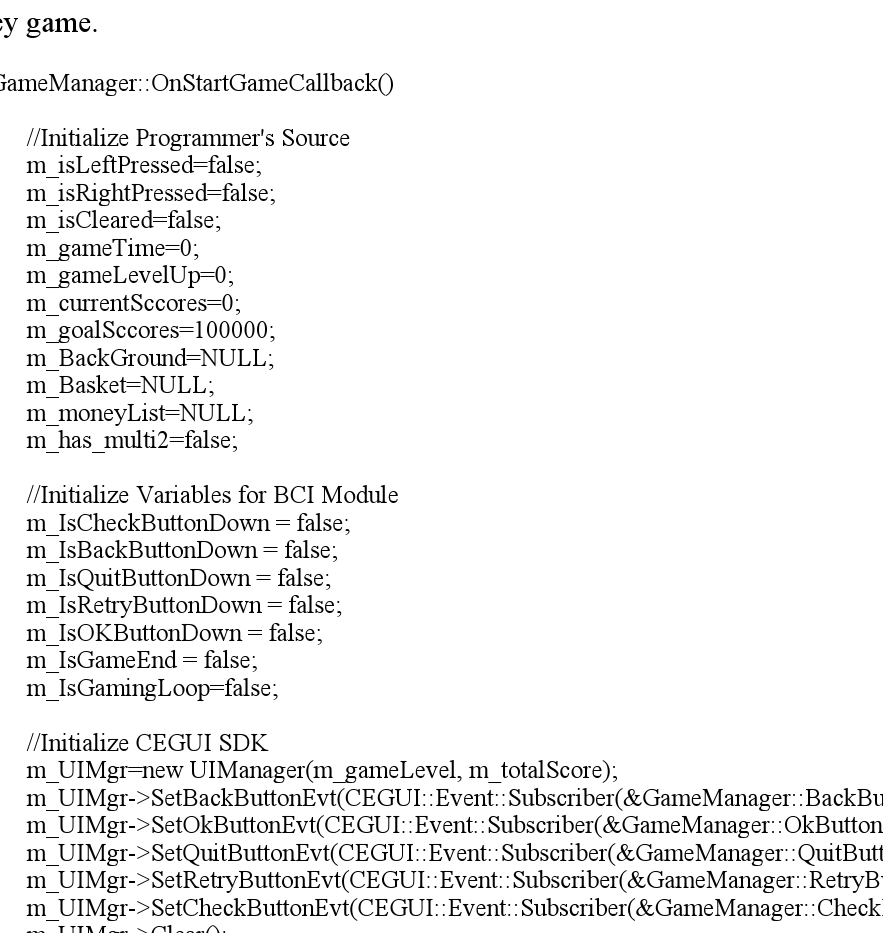
Figure 11. Implementation of Function OnStartGameCallback. This function initializes the money